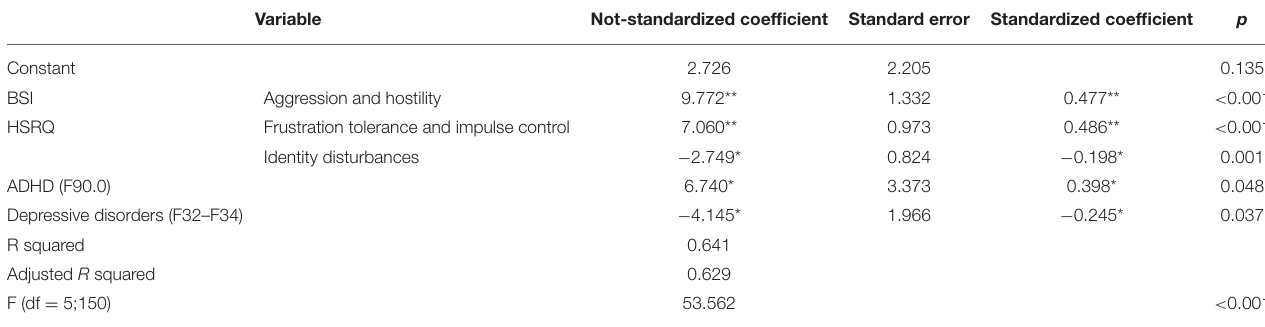
TABLE 4 | Multiple linear regression using RAQ-R as dependent